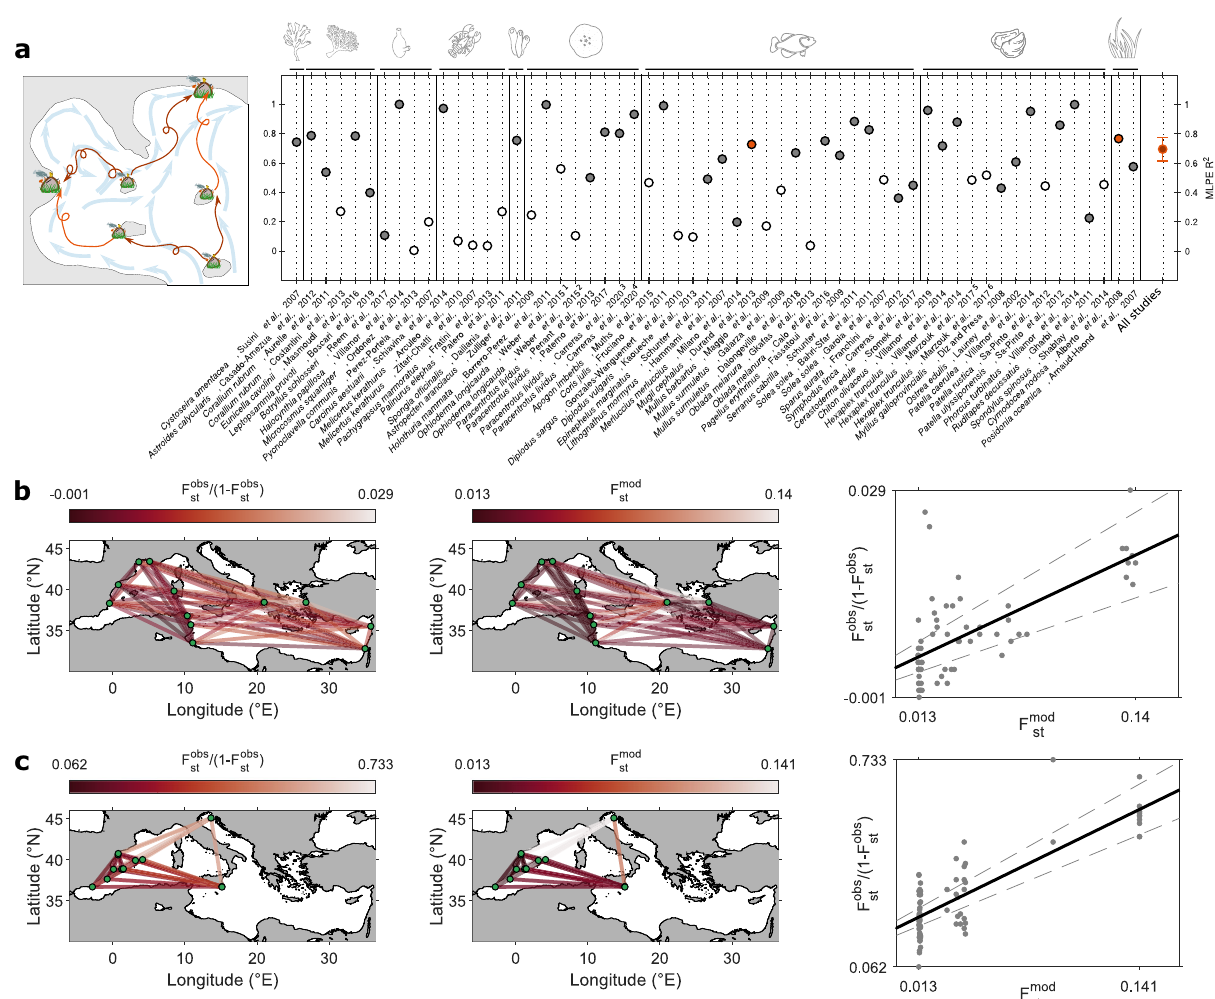
Fig.4|Accuracyofthemulti-generationimplicitdispersalmodelinexplaining compiled genetic structures. a MLPE linear mixed model R 2 between F mod st and F obs st = ð 1 (cid:2) F obs st Þ . Filled dots highlight the 37 signi fi cant correlations ( p value*). Note that some results reported by a given study are analyzed separately: (i) Weber et al. 87 used nuclear DNA marker ( 1 ) and mtDNA marker ( 2 ); (ii) Carreras et al. 58 consideredallthelocitogether( 3 )andthenonlytheMediterraneanoutliersloci( 4 ); (iii) Marzouketal. 88 analyzednuclearDNA marker ( 5 ) and mtDNA marker ( 6 ).Error- bars for all studies represent the 95 % con fi dence intervals. b Network